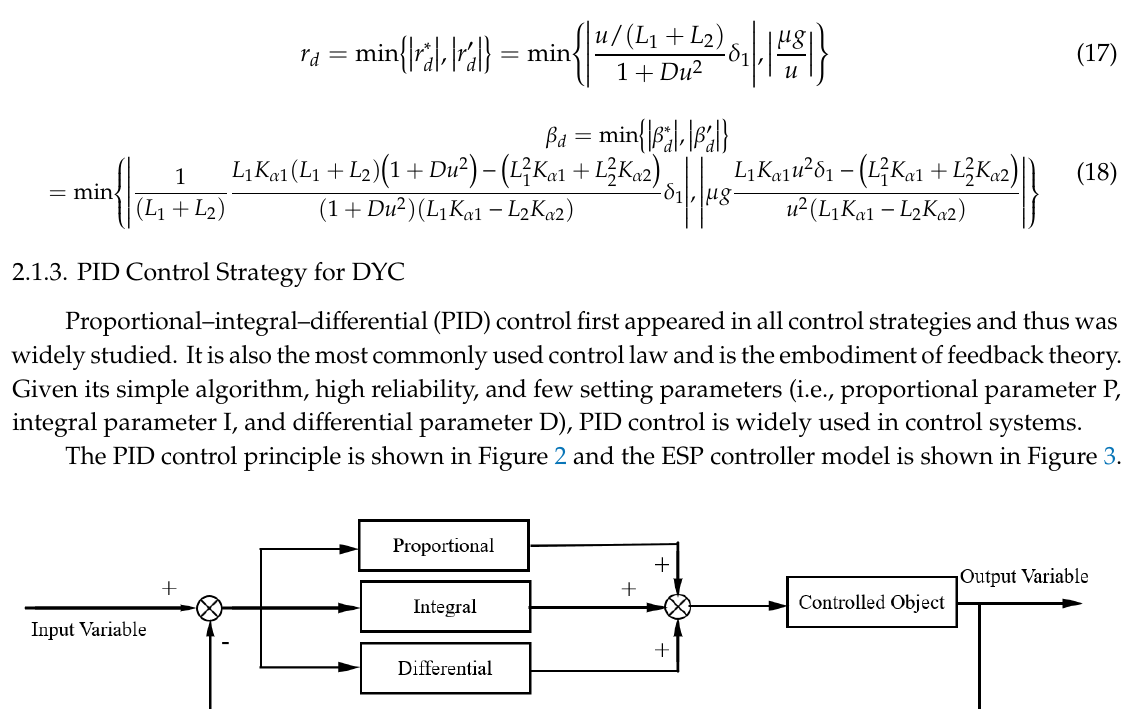
Figure 3. Electronic stability program (ESP) controller model. According to the monorail model with two degrees of freedom, the ideal values of yaw rate and mass sideslip angle of the ESP control system are generated, and the difference is calculated with the actual measured yaw rate and the center of the mass sideslip angle. PID control is carried out to output the difference of the left and right wheel moments. 3. Design of Multi-Objective Fuzzy Continuous Damping Controller CDC suspension can guarantee the comfort of passengers under good level road conditions. The damping forces in the suspension can be changed through the control function of CDC suspension. This step can reduce the vehicle roll degree and change the vertical load distribution of the vehicle so as to aid the ESP. The vertical force on the suspension of each wheel can be expressed by the following equations, and the suspension model is shown in Figure 4. 𝐹 𝑣𝑙1 = 𝐾 𝑠𝑙1 (𝑍 𝑢𝑙1 − 𝑍 𝑠 + 𝐿 1 sin 𝜃 + 𝐵 1 2 sin 𝜑) + 𝐶 𝑠𝑙1 (𝑍 𝑢𝑙1 ̇ − 𝑤 + 𝐿 1 𝑞 cos 𝜃 + 𝐵 1 2 𝑝 cos 𝜑 )